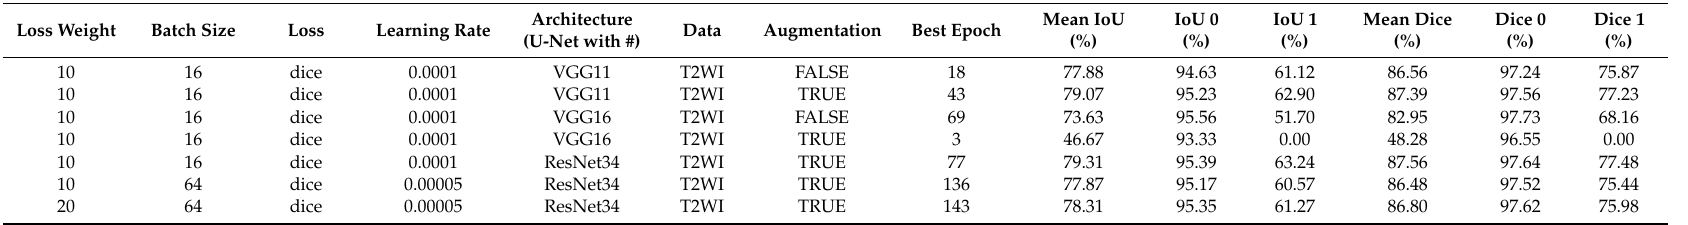
Table A7. Parameters and performance of all three architectures on “T2w” of the